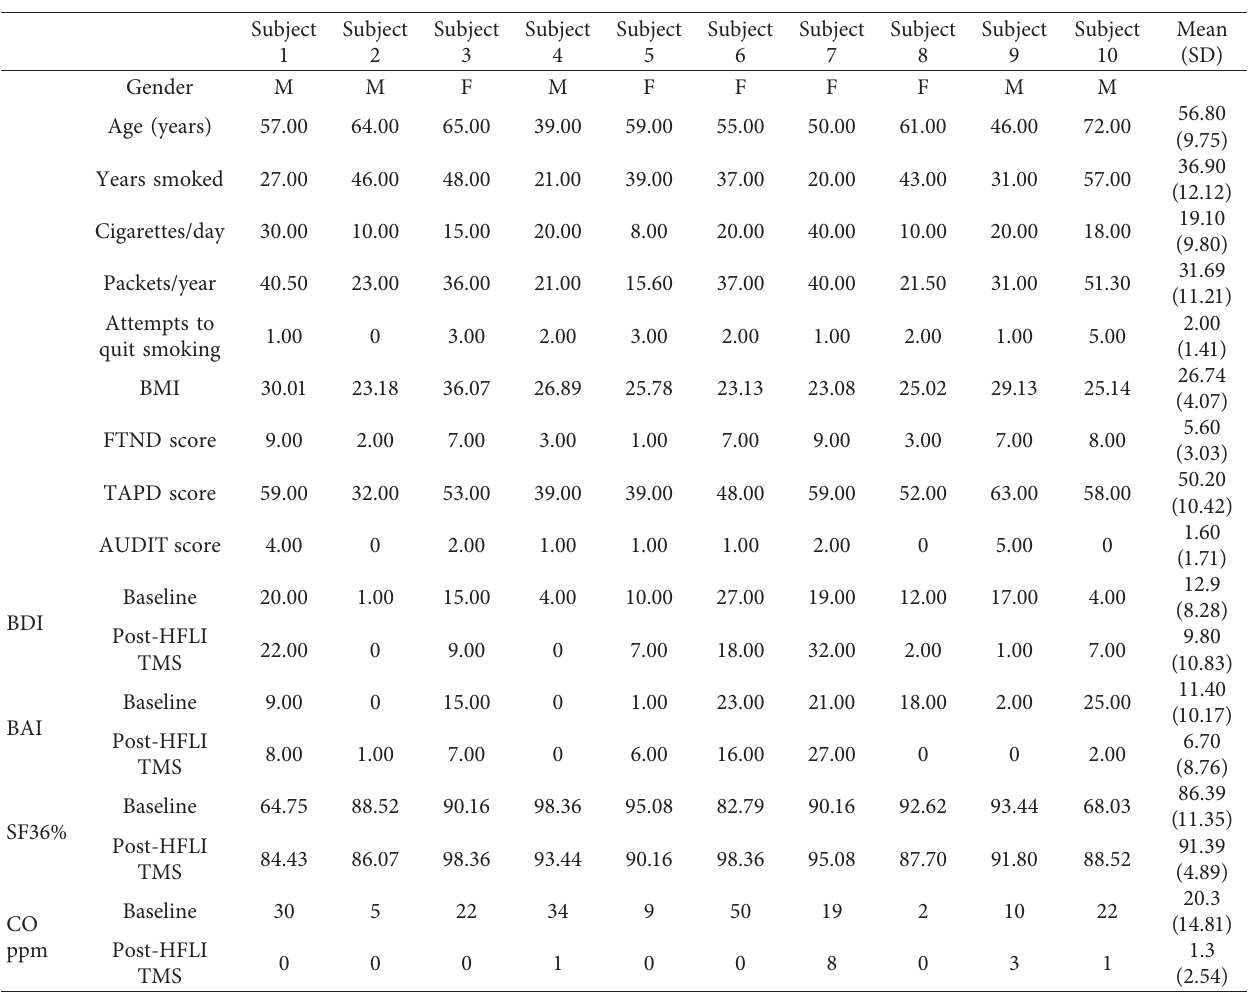
Table 1: Clinical and epidemiological data of reported